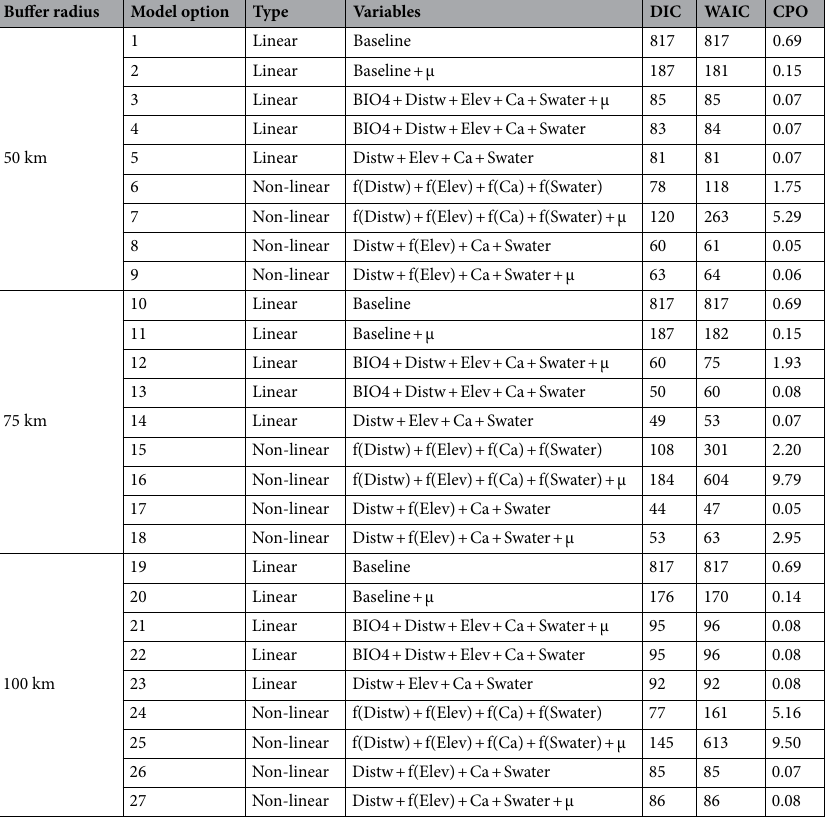
Table 2. Model comparison of the fitted INLA models using linear and non-linear associations across three background buffer radii. The criteria for comparison are DIC Deviance Information Criterion, WAIC Watanabe-Akaike Information Criterion, LCPO Conditional Predictive Ordinate, Variables acronyms are Distw Distance to water, Ca Soil calcium, Elev Elevation, Swater Soil water, BIO4 Temperature Seasonality, µ Spatial